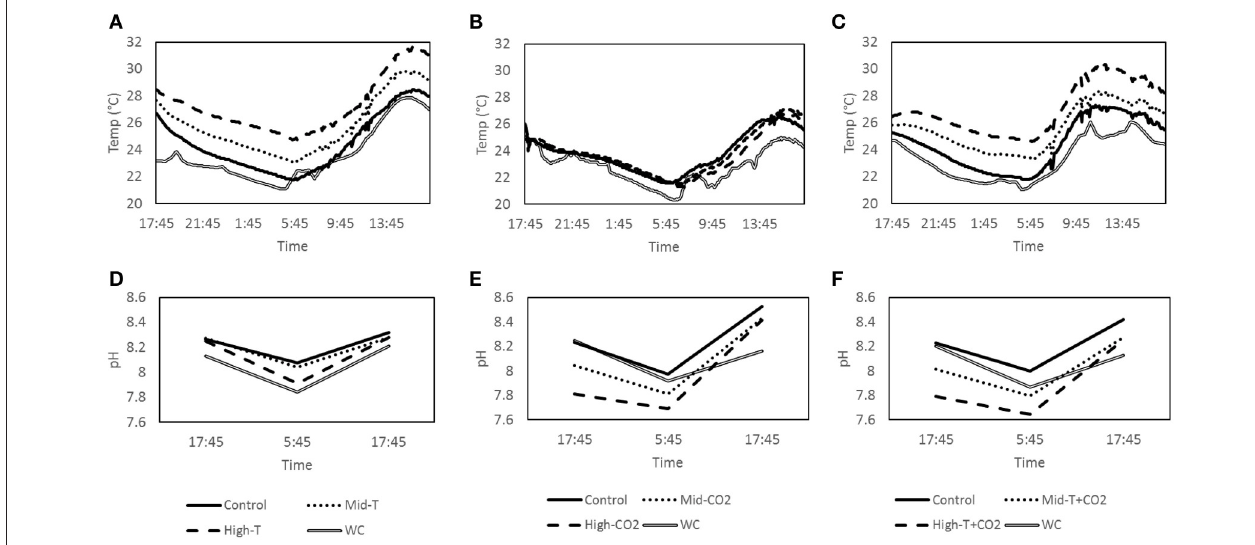
FIGURE 1 | Average temperature ( n = 3) inside the treatment chambers, control chambers and the water column for incubations T (A) CO 2 (B) and T + CO 2 (C). Average pH ( n = 3) inside the treatment chambers, control chambers and the water column for incubations T (D) CO 2 (E) and T + CO 2 (F)